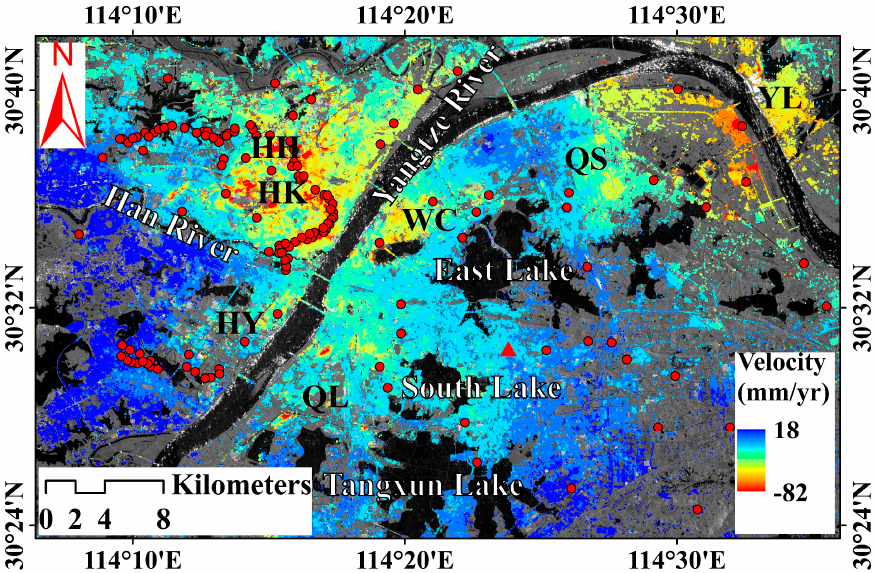
Figure 6. Distribution of benchmarks for surface subsidence monitoring over Wuhan. The red circle and triangle denote leveling point and reference point, respectively.